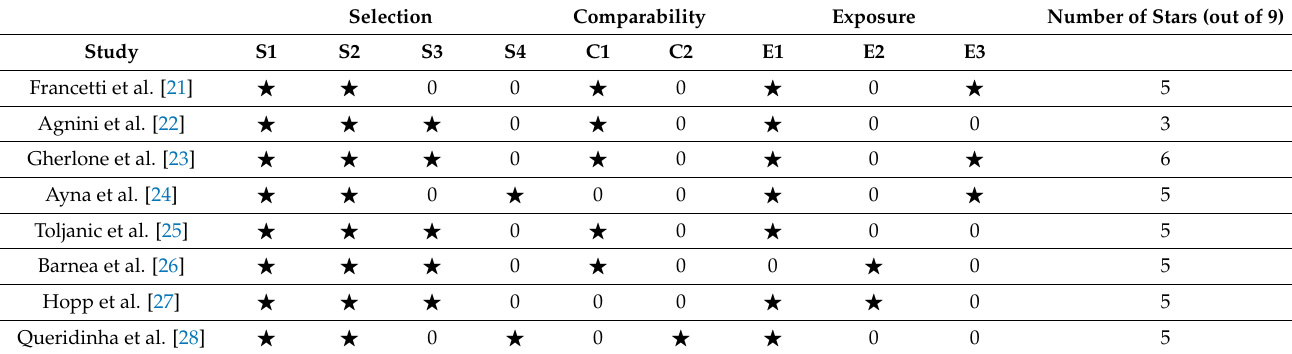
Table 4. Quality assessment of studies reviewed using the Newcastle–Ottawa scale